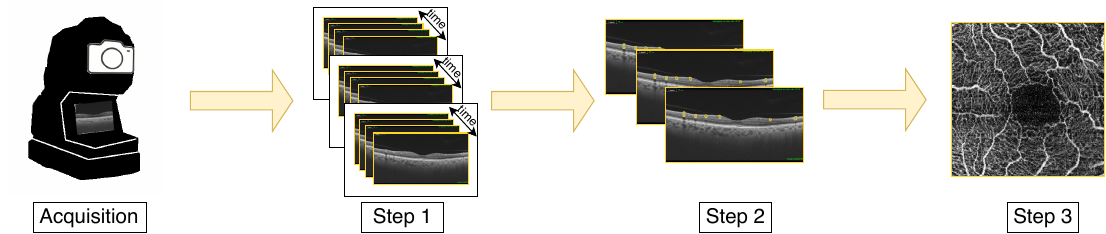
Figure 3. Graphical scheme of the Optical Coherence Tomography Angiography (OCTA) image acquisition